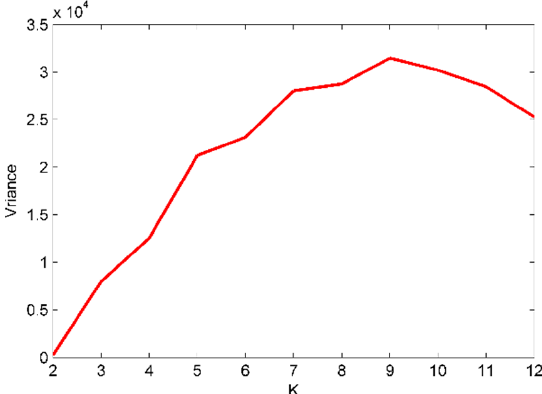
Figure 3. The variance curve of intrinsic mode functions (IMFs) center frequency with mode number K after simulated signals decomposition using variational mode decomposition (VMD). When the mode number K is set to be more than the good, estimated value K = 9,